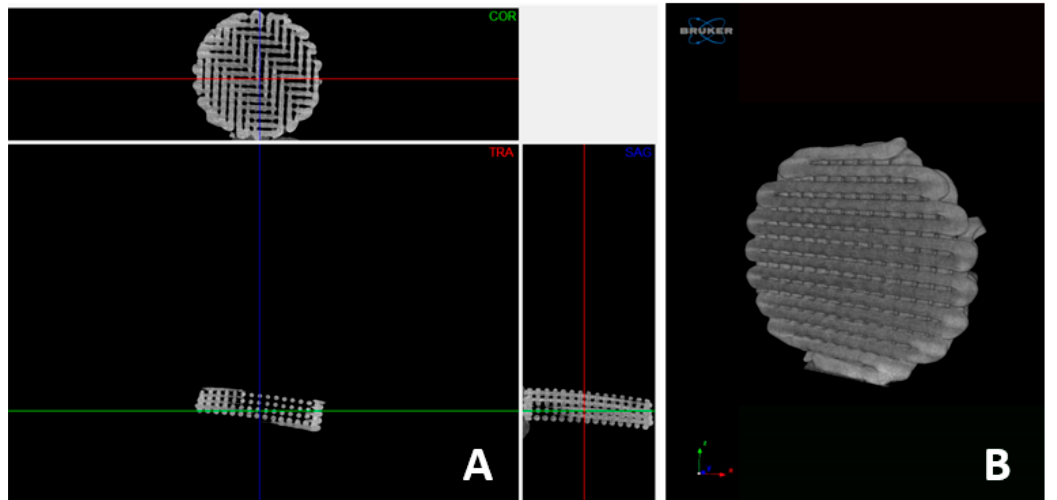
Figure 4. The 3D projections: Micro-CT generated 3-dimensional projections: ( A ) transversal plane views; ( B ) micro-computed tomography ( µ -CT) 3D reconstruction of a representative extruded PCL chromatographic structure.